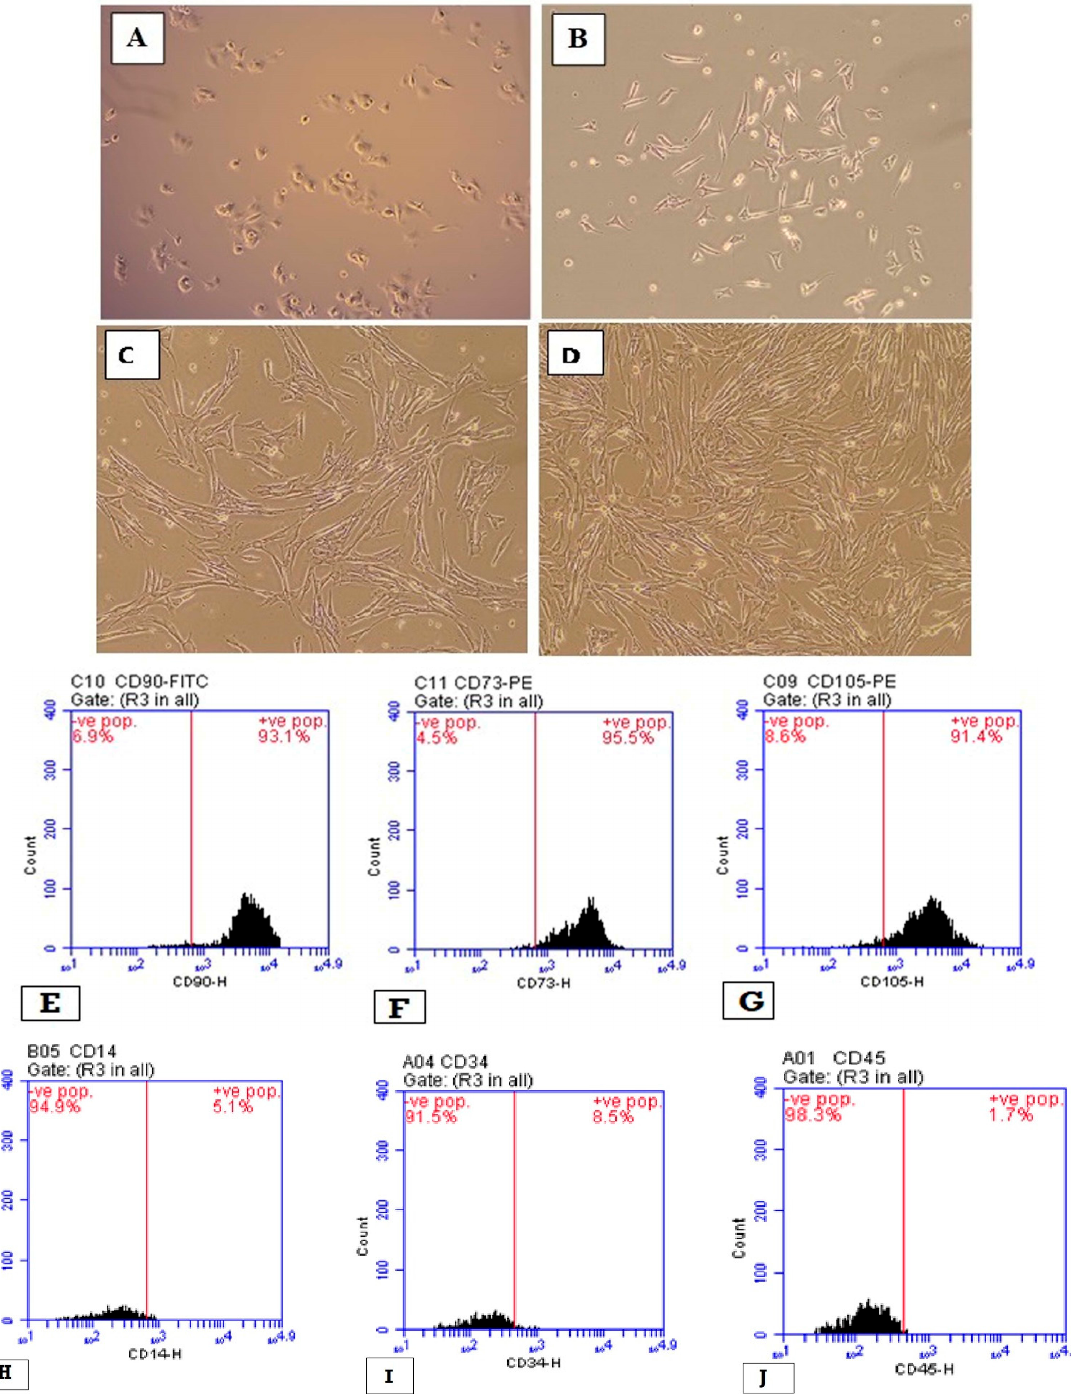
Figure 1. WJ-MSCs in tissue cultures and their characterization. ( A ) shows images of WJ-MSCs alone on day 1 (100× magnification), while ( B ) shows images of WJ-MSCs alone at passage 3 (100× magnification). ( C ) shows WJ-MSCs which have a mesenchymal-like shape with a flat polygonal morphology (100× magnification), and ( D ) shows WJ-MSCs treated with 10 µM ATRA with 80% confluence (100× magnification). Flow cytometry histograms for WJ-MSCs showing positivity for CD90 ( E ), CD73 ( F ), CD105 ( G ) and negativity for CD 14 ( H ), CD34 ( I ) and CD45 ( J ). WJ-MSCs = Wharton jelly-mesenchymal/stromal stem cells.